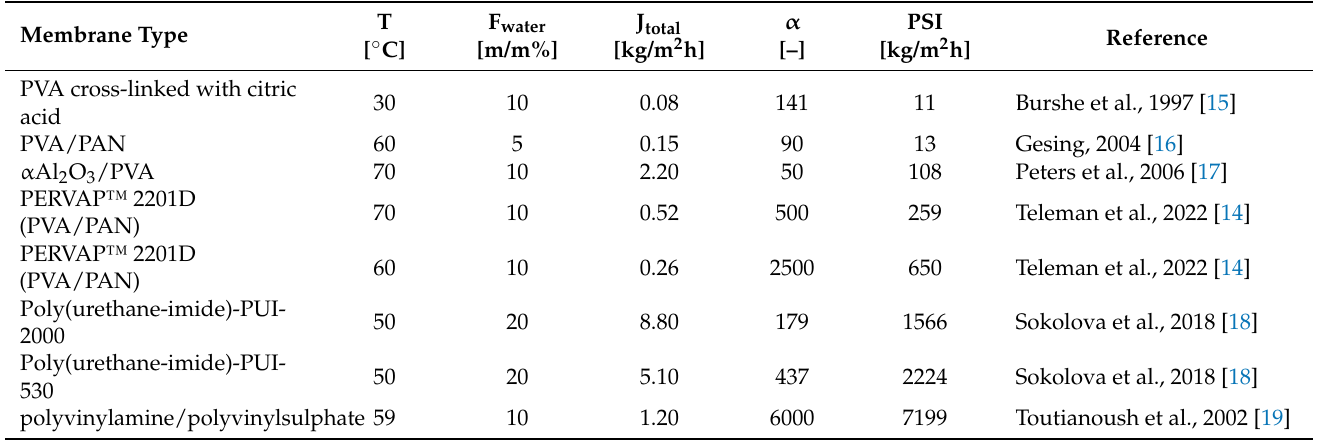
Table 1. Summary of measured data for hydrophilic pervaporation of n-propanol–water mixture (based on, expanded